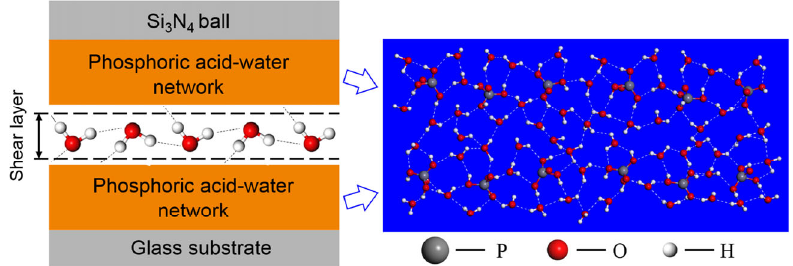
Fig. 3 Schematic illustration of the liquid lubricating film between two friction surfaces (left) and the possible molecular schematic representation of phosphoric acid-water network (right)